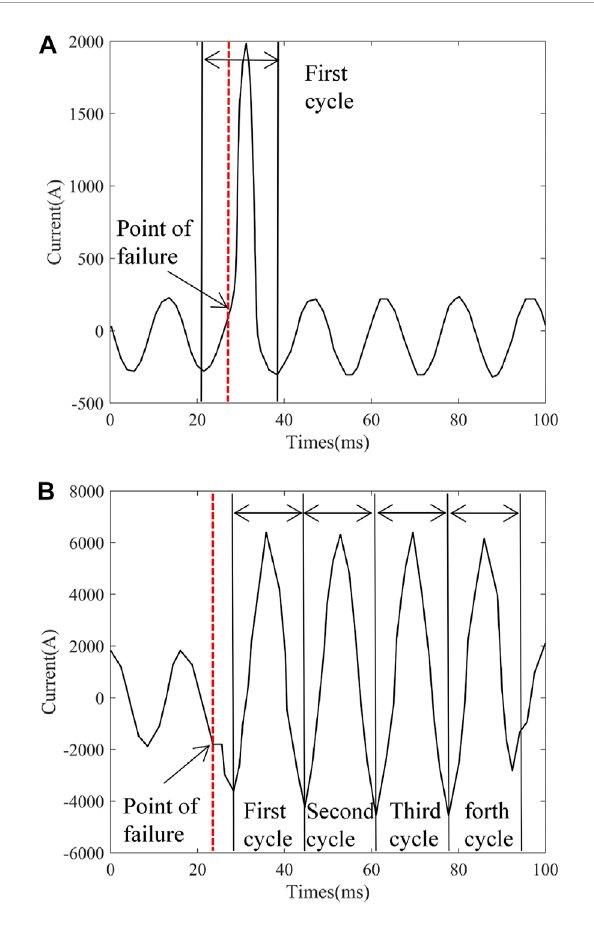
FIGURE 6 The current waveform of fault phase in sub-cycle incipient fault and multi-cycle incipient fault from cable. (A) Sub-cycle incipient fault, (B) multi-cycle incipient